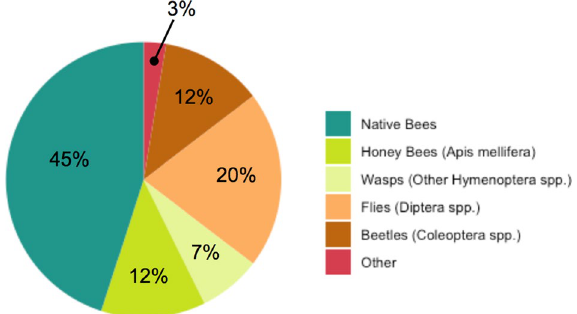
Figure 6. Percentage of pollinating insects contributed by different taxonomic groups, indicated by color.